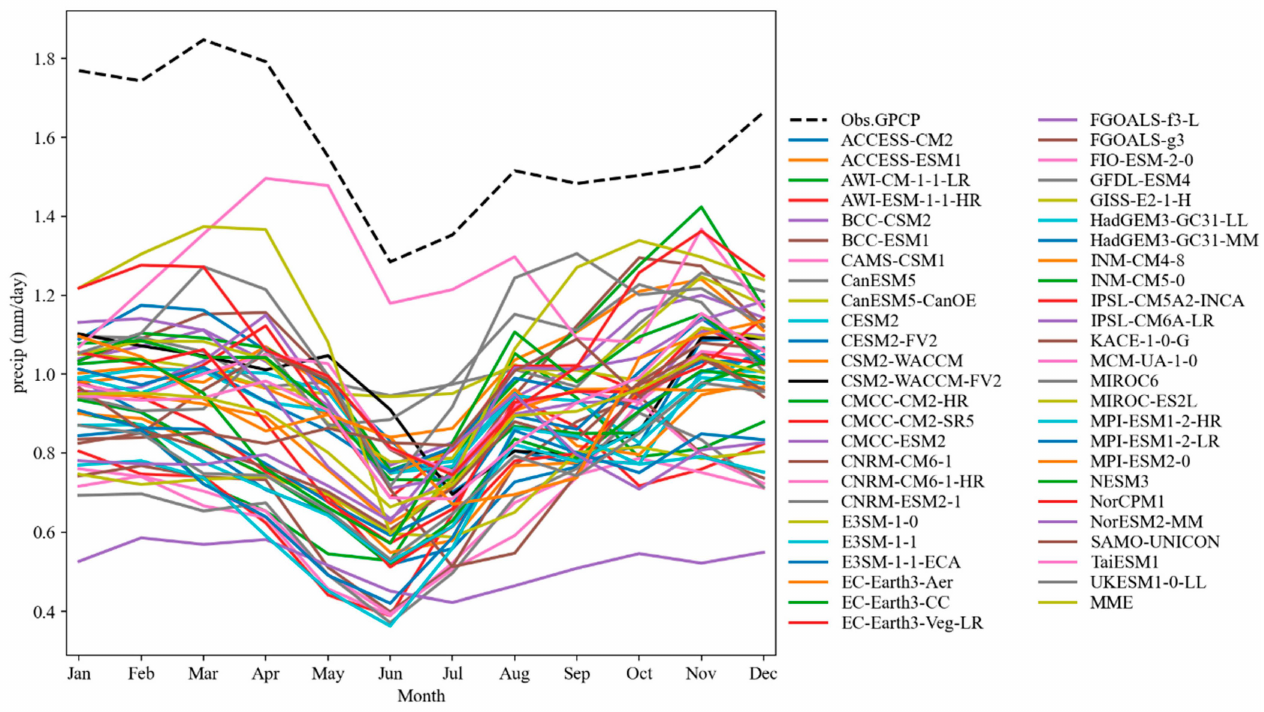
Figure 6. Annual cycle of precipitation (mm) in GPCP (dotted black line) and CMIP6 models (colored lines) averaged over the period from 1980 to